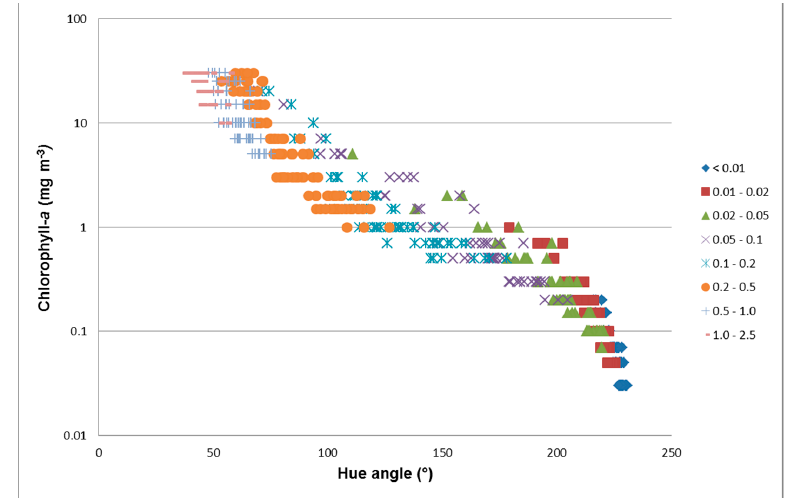
Figure 7. Relation between the hue angle and chlorophyll- a concentration (CHL) for eight classes of Coloured Dissolved Organic Matter (CDOM) concentration. The first four classes (0.001 < g440 < 0.1) can be found in the open ocean, while the next two (0.1 < g440 < 0.5) represent regional seas and coastal